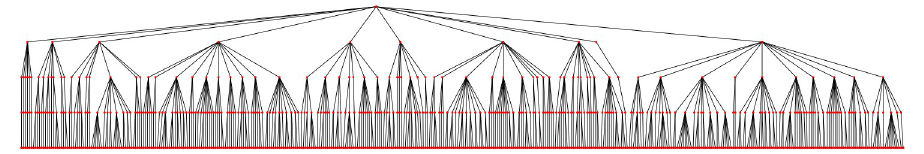
Fig 2. The SIC hierarchical classification tree of the documents in the training corpus, with Divisions (top level), Major Groups (second level), Industry Groups (third level), and Codes (bottom level).